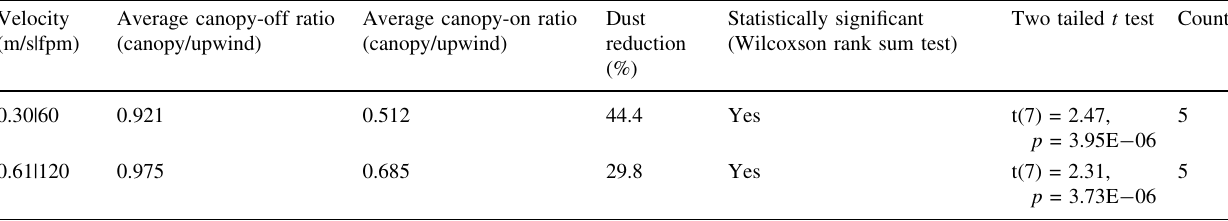
Table 11 Summary of dust control efficiency for the CAC at 10-in. height underneath the canopy using Small Fan #1 Velocity Average canopy-off ratio (m/s|fpm) (canopy/upwind)